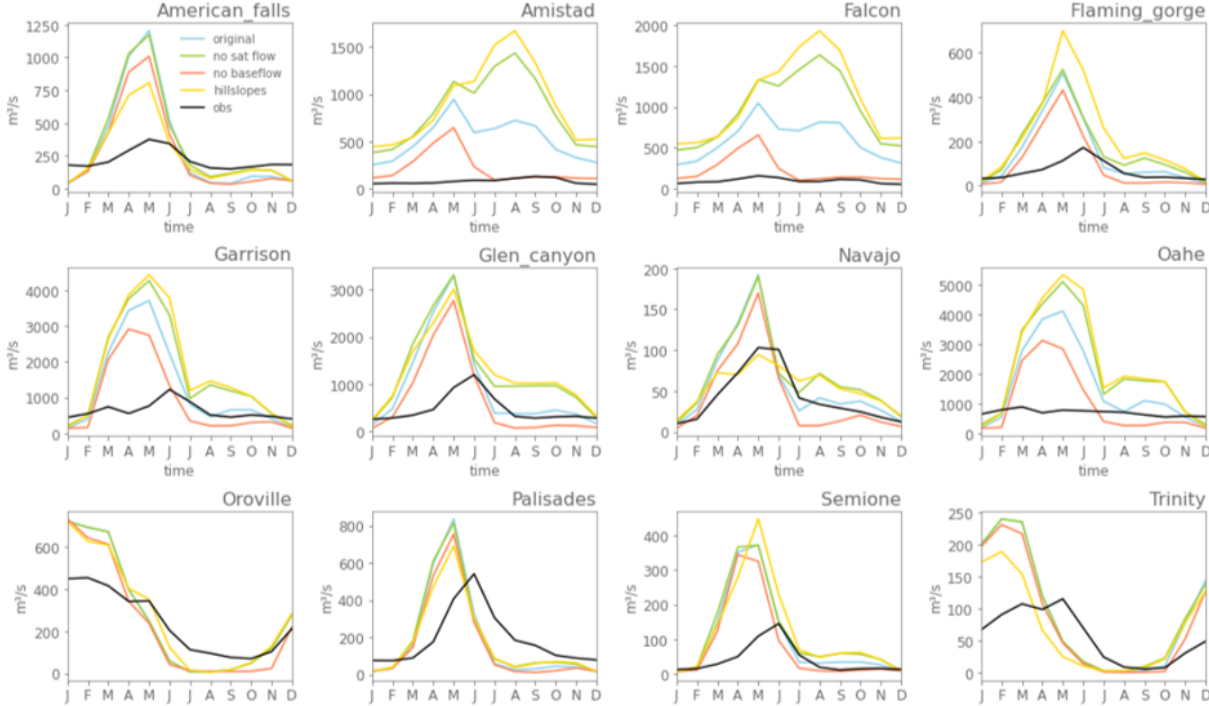
Figure A7. Simulated and observed inflow seasonality per reservoir with mizuRoute using runoff from different CLM simulations at 0.125 ◦ resolution with meteorological forcing from NLDAS. In the legend, “original” refers to the simulation with the default CLM version used in the main analysis, “no sat flow” refers to the simulation where surface saturation excess runoff is set to 0, “no baseflow” refers to the simulation with a decreased baseflow parameter, “hillslopes” refers to the simulation using the hillslope model described in Swenson et al. (2019) and performed at 0.5 ◦ horizontal resolution, and “obs” are the observed inflows from the Yassin et al. (2019) dataset.